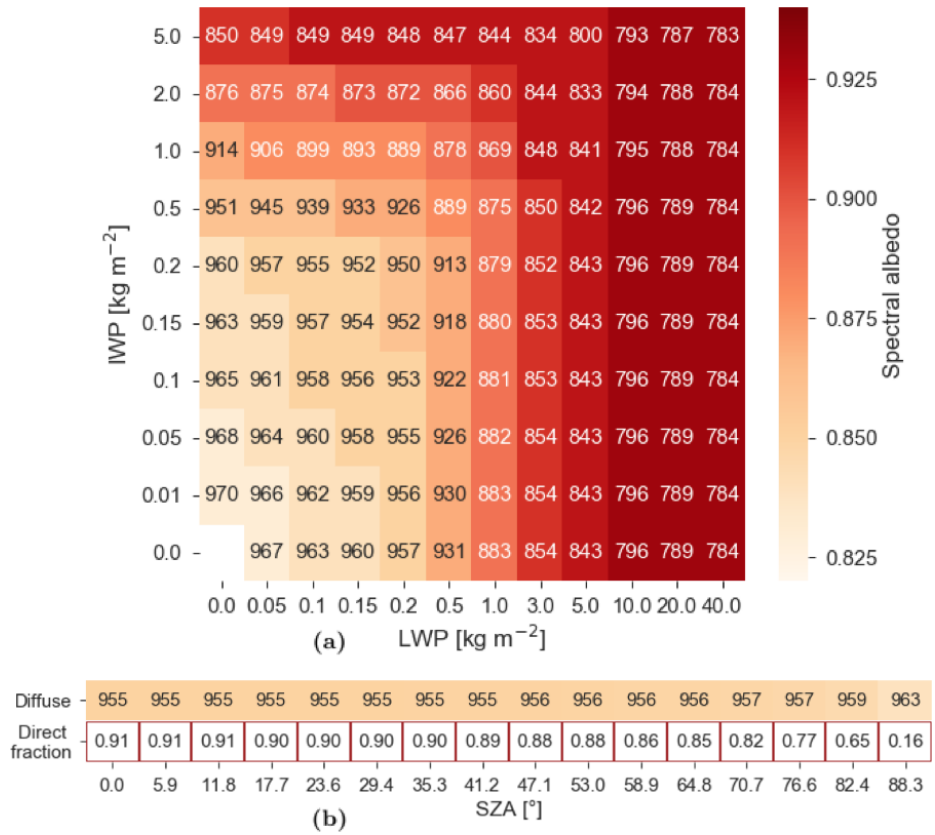
Figure 9. Final lookup table with RWs for band 6. Colors express the corresponding albedo for the default snowpack. (a) The two- dimensional table for overcast conditions, depending on IWP and LWP, and (b) clear-sky conditions table for diffuse radiation and the fraction of incoming radiation that is direct as a function of SZA. The white square at LWP, IWP=0.0kgm − 2 of the overcast table in panel (a) indicates the conditions when the clear-sky table of panel (b) is required. The lookup table for direct radiation is not shown but is similar to panel (a) with SZA and IWV as